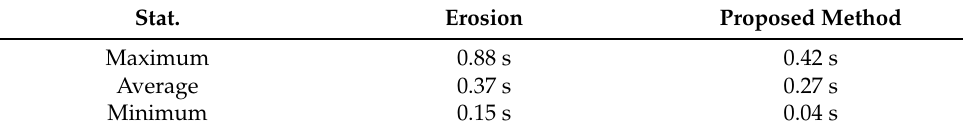
Figure 10. Processing times in seconds. Table 1. Statistics of processing times for erosion and the proposed methods in seconds. Stat.